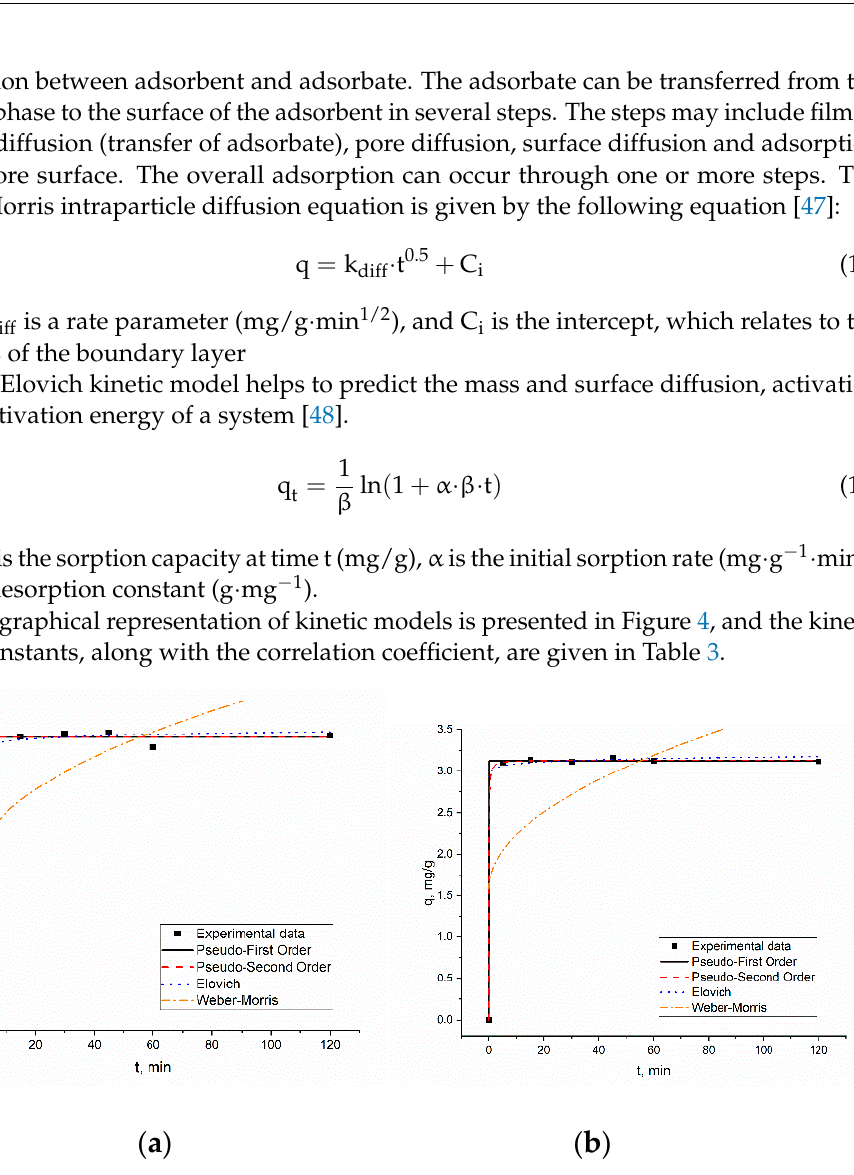
Figure 4. Kinetics of Cu(II) sorption on ( a ) mesoporous silica SBA-15 and ( b ) titanosilicate ETS-10 adsorbents. Table 3. Parameters of the applied kinetic models for the adsorption of Cu(II) on SBA-15 and ETS- 10.